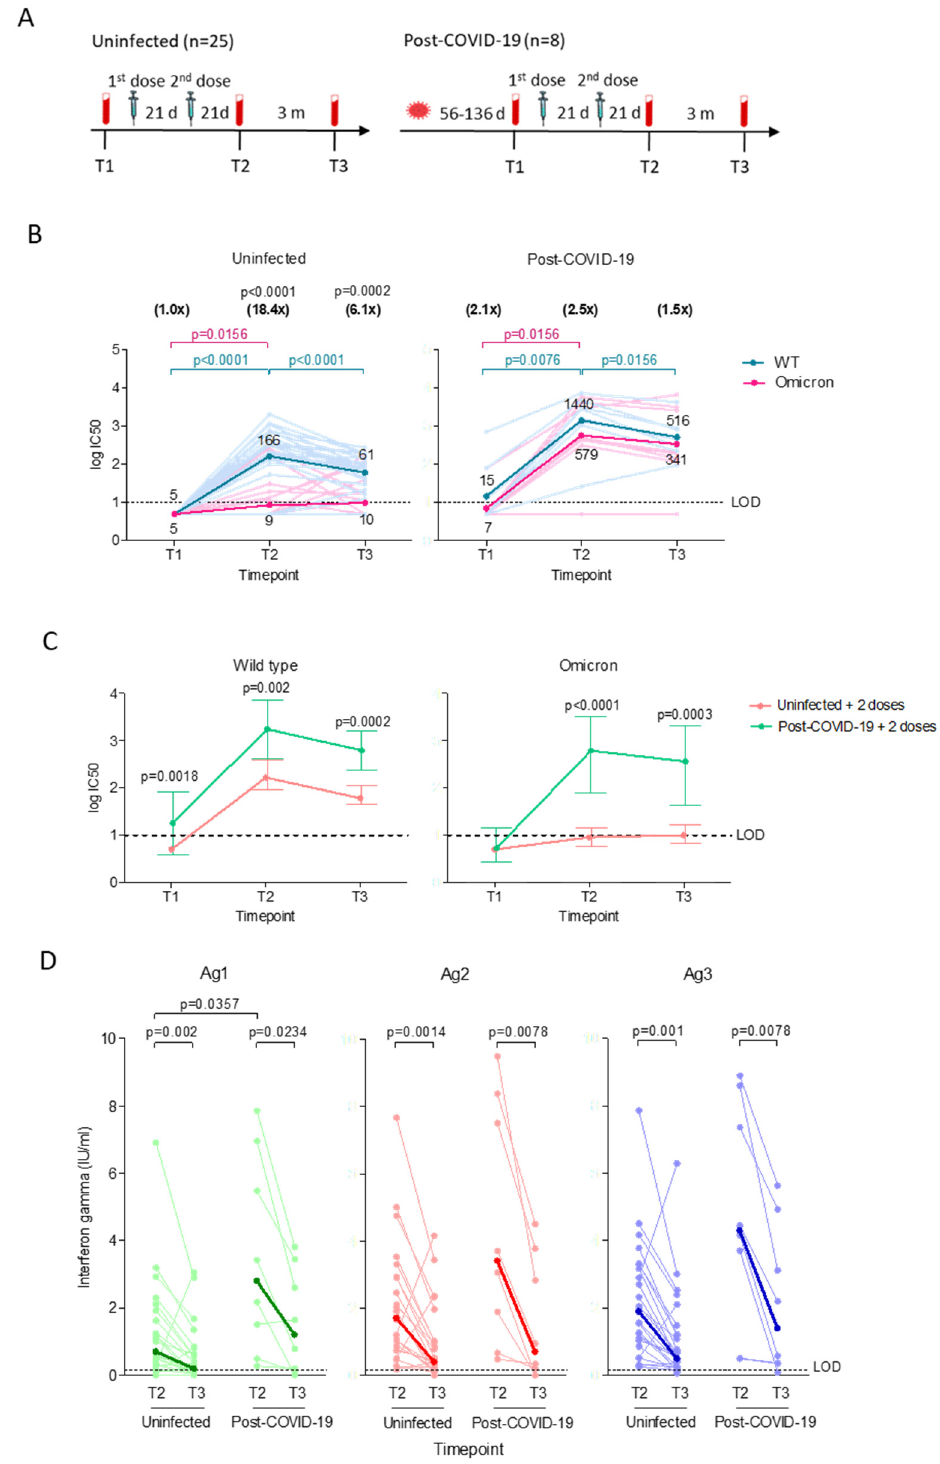
Figure 1. Neutralizing antibody and T cell immune responses after two doses of vaccines in uninfected ( n = 25) and post-COVID-19 individuals ( n = 8). ( A ) Longitudinal study design. Plasma samples were collected before the first vaccine dose (T1), and 21 days (T2) and 3 months (T3) after the second dose. ( B ) Neutralizing antibody titers (log IC 50 ) against pseudoviruses bearing wild type (WT) or Omicron spike proteins. Significant differences within groups were assessed with the two-tailed Wilcoxon matched-pair signed rank test. The horizontal lines represent neutralizing antibody titers of individual samples against WT (light blue) and Omicron (light pink). The dark blue (WT) and dark pink (Omicron) lines represent the geometric means of log transformed values. P values